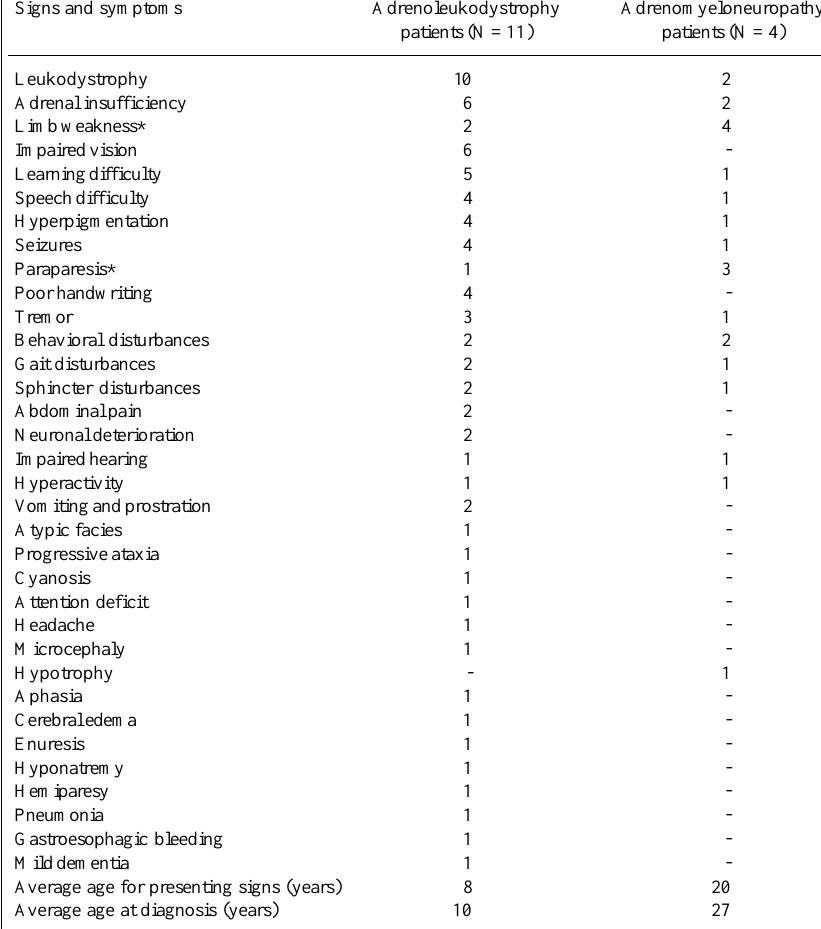
Table I - Frequency of signs and symptoms in the 15 X-linked adrenoleukodystrophy Brazilian patients.